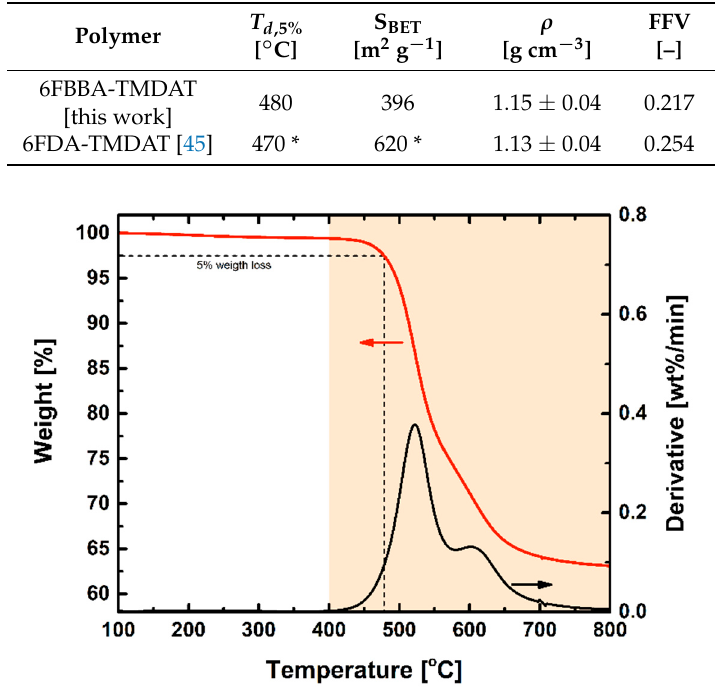
Figure 3. N 2 atmosphere TGA analysis of methanol-treated 6FBBA-TMDAT polyamide film dried under vacuum at 130 °C for 24 h.